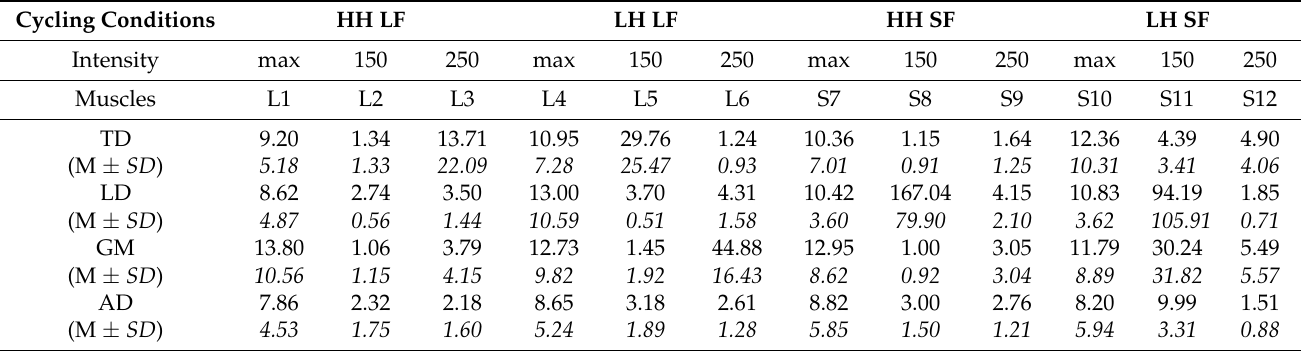
Table 2. Percentage of average rectified value for electromyographic activity of four muscles under different handlebar height and bicycle frame length conditions during cycling. Data expressed as percentage of maximum voluntary contraction (%